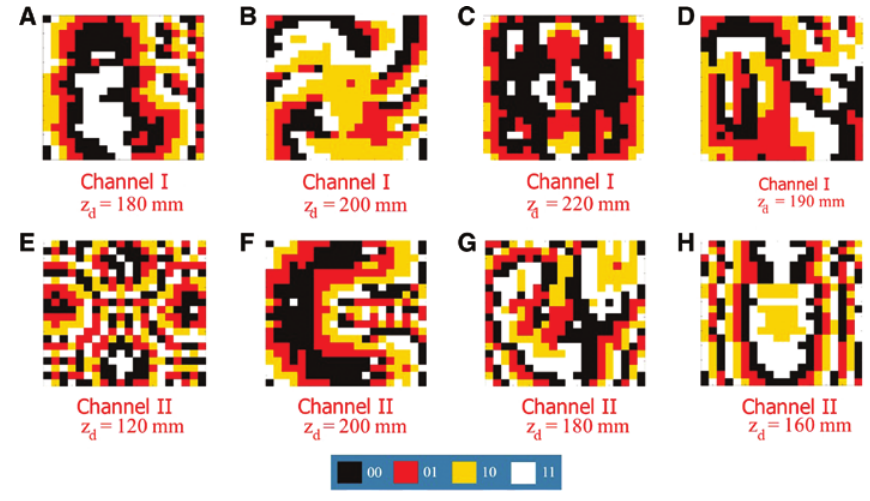
Figure 4: The binary phase maps of the reflective coding meta-hologram for low-frequency (top row) and high-frequency (bottom row) holographic images of (A), (E) “L”/four disordered hotspots, (B), (F) “S”/“C”, (C), (G) “H”/“V”, and (D), (H) “U”/“i” letters. The phase-only profiles have been extracted by using the WGS retrieval algorithm and could be realized with the 2-bit coding elements of Figure 2B. Indeed, there are in total four different designs of metasurfaces, each of which was imparted with two phase maps given in each column at two frequencies of 10 GHz and 15